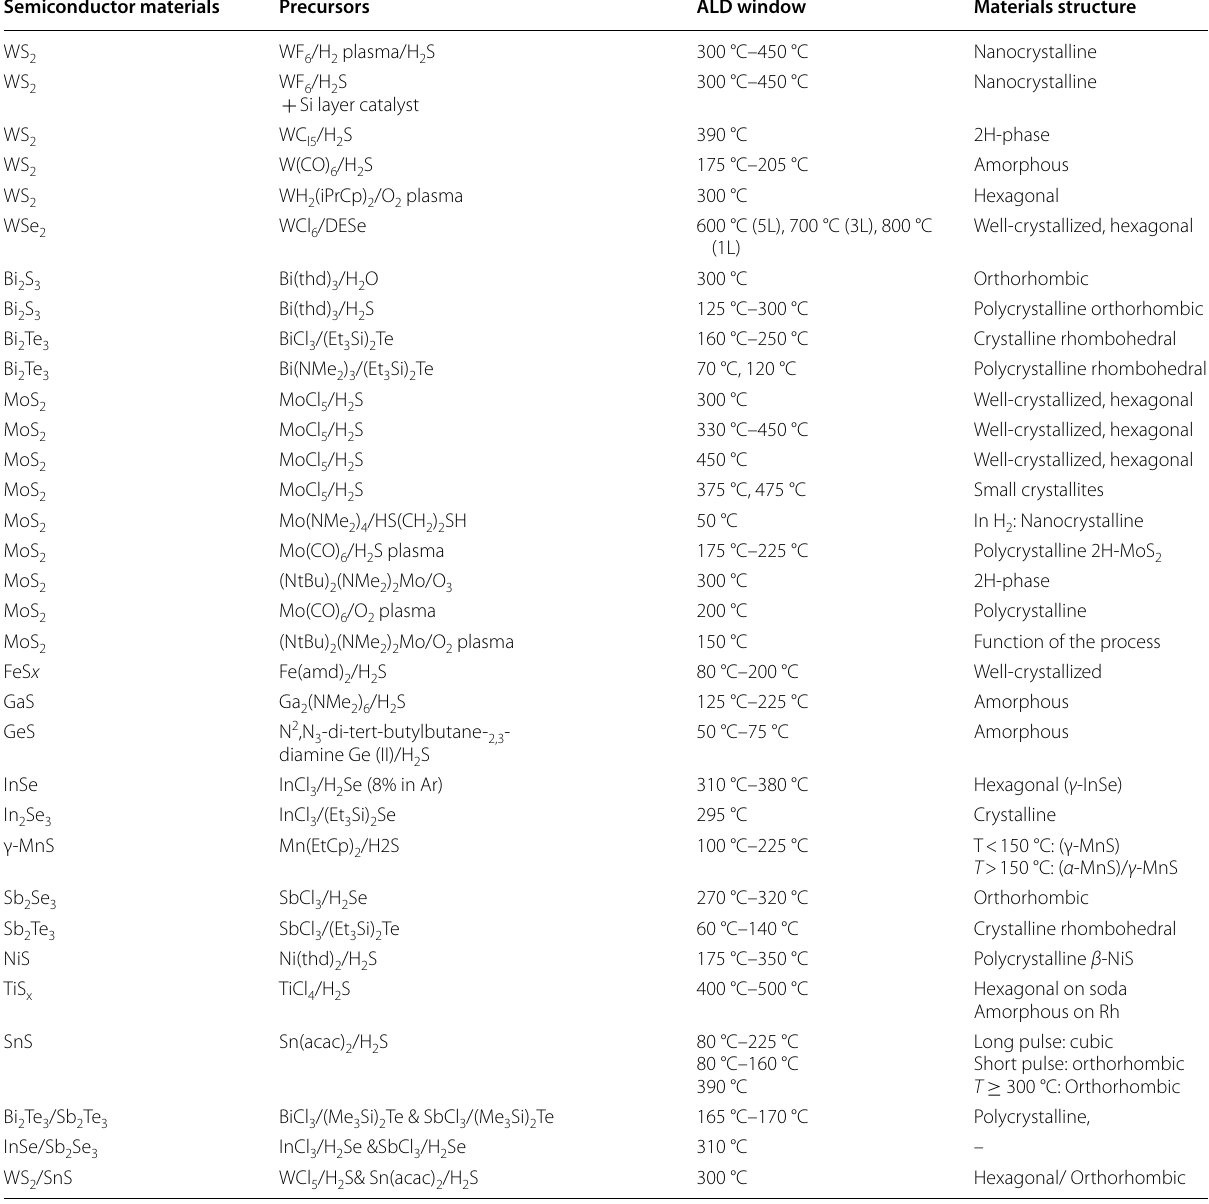
Table 2 Review of the reported ALD deposition of ultra-thin 2D TMDC nanofilms. Reprinted with permission from [94] Semiconductor